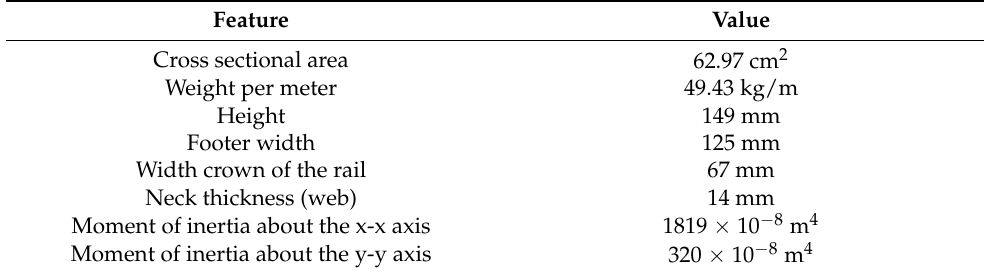
Table 1. Technical parameters of the S49 (49E1)-type rail.